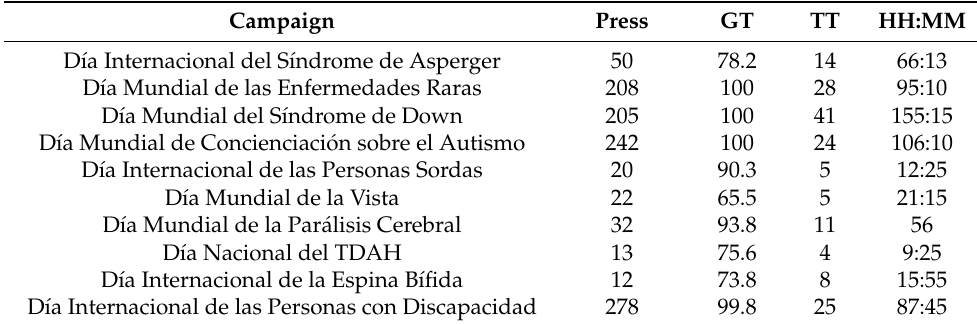
Table 3. Relationship among the indicators for the period from 2015 to 2020 1 .